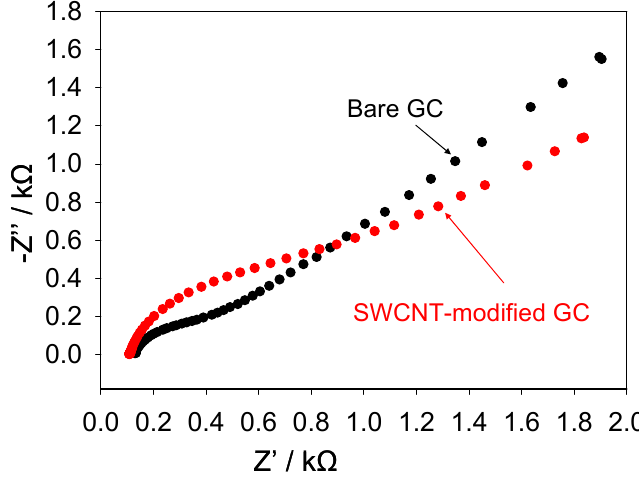
Figure 10. Complex impedance Nyquist plots recorded for ferricyanide reduction at GC and SWCNT modified GC